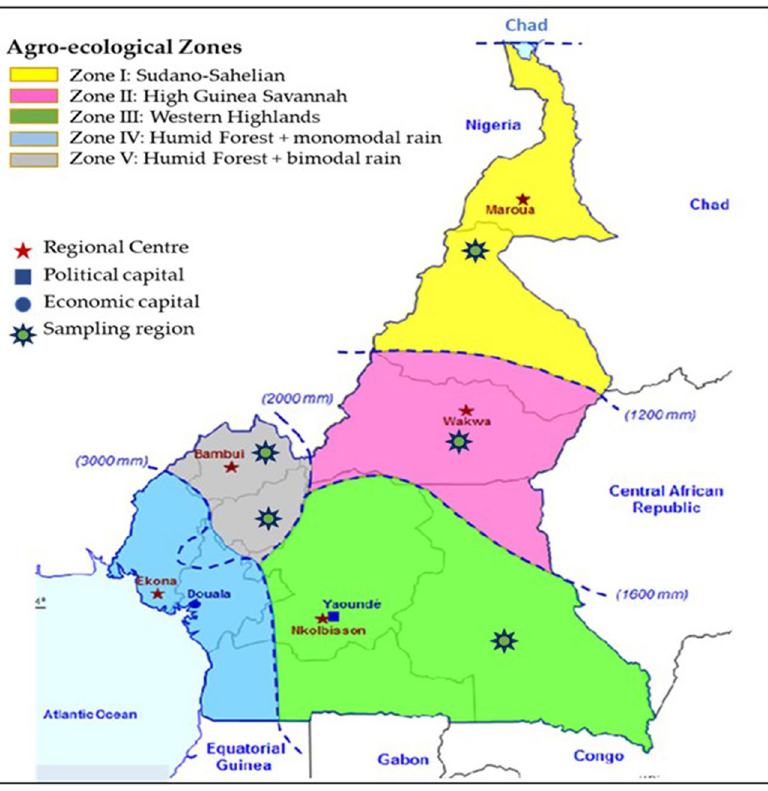
Figure 1. A map of Cameroon showing agroecological zones, regional centres, political and economic capitals and Urochloa seeds sample collection regions (https:// agrit rop. cirad. fr/ 556139/ 1/ docum ent_ 556139. pdf ).